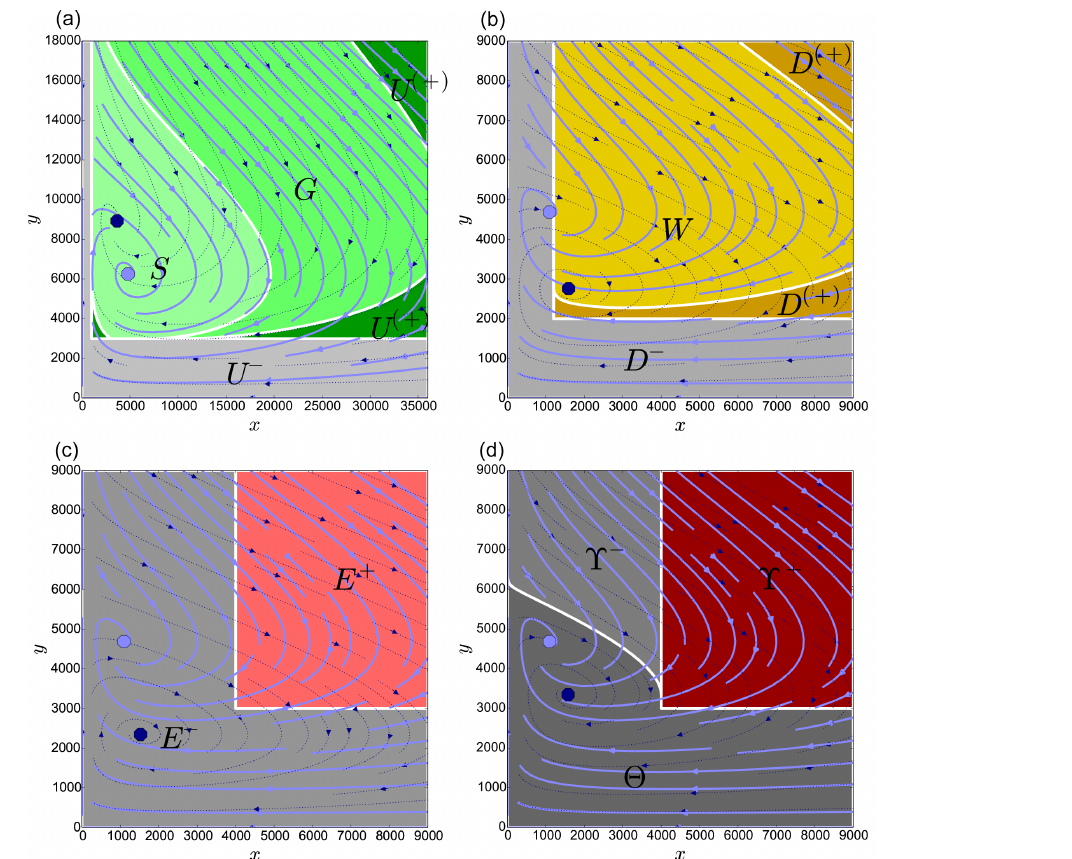
Figure 7. Combined population and resource dynamics. Coevolution of a population x and a resource stock y . In all cases, φ = 4, r = 0.04. When the globally stable fixed point of the default dynamics (pale blue) falls into X + , only upstream regions occur (top-left panel, γ 0 = 4 × 10 − 6 >γ 1 = 2.8 × 10 − 6 , δ =− 0.1, κ = 12000, x min = 1000, y min = 3000). When it falls into X − instead, but the sta- ble fixed point of the alternative management trajectory (dotted dark blue) is in X + , then only downstream regions occur (top-right panel, γ 0 = 8 × 10 − 6 <γ 1 = 13.6 × 10 − 6 , δ =− 0.15, κ = 6000, x min = 1200, y min = 2000). Otherwise (bottom panels, γ 0 = 8 × 10 − 6 <γ 1 , δ =− 0.15, κ = 6000, x min = 4000, y min = 3000), the analysis depends on whether one can repeatedly reach X + by switching between de- fault and alternative trajectories: for γ 1 = 16 × 10 − 6 (bottom-left panel), only eddies occur, while for γ 1 = 11.2 × 10 − 6 (bottom-right panel), only abysses and trenches